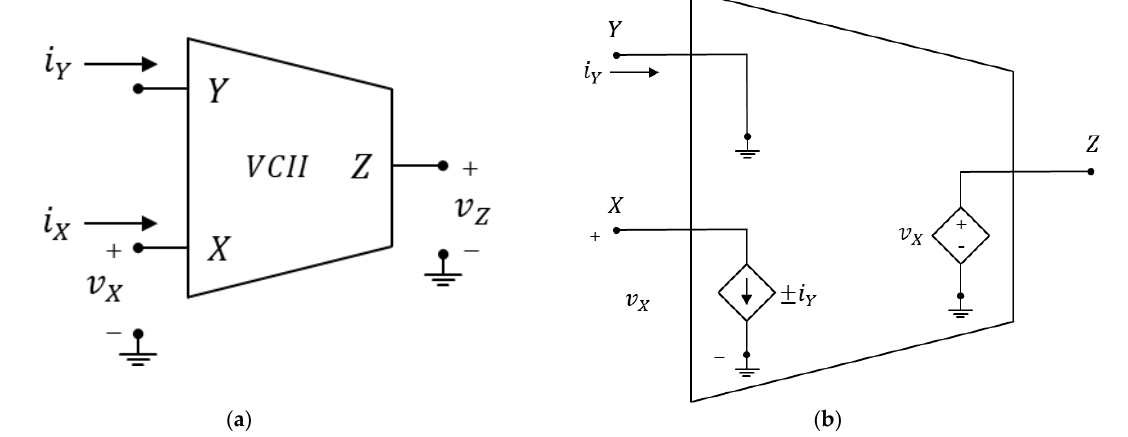
Figure 3. Second generation voltage conveyor: ( a ) circuit symbol, ( b ) equivalent circuit.